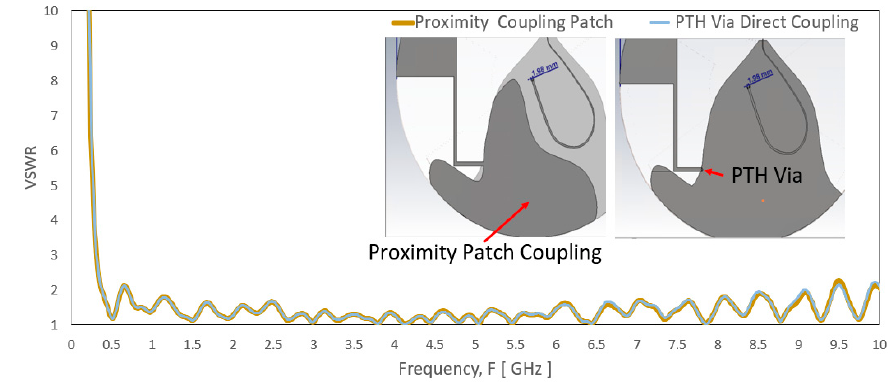
Figure 8. The simulated VSWR between using proximity coupling patch and PTH via direct coupling at the end of the shorting line to the ground plane.